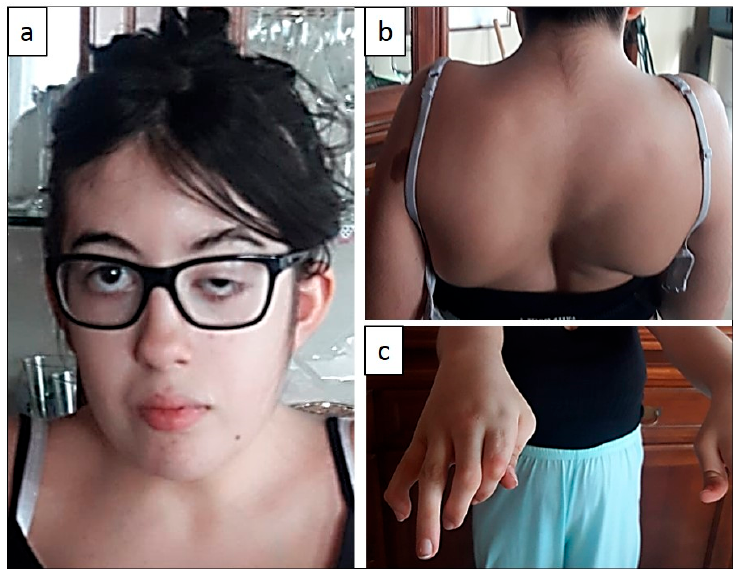
Figure 1. Patient 1. ( a ) Unilateral ptosis, strabismus, and short neck. ( b ) Severe right camptotactyly. ( c ) Left convex scoliosis.